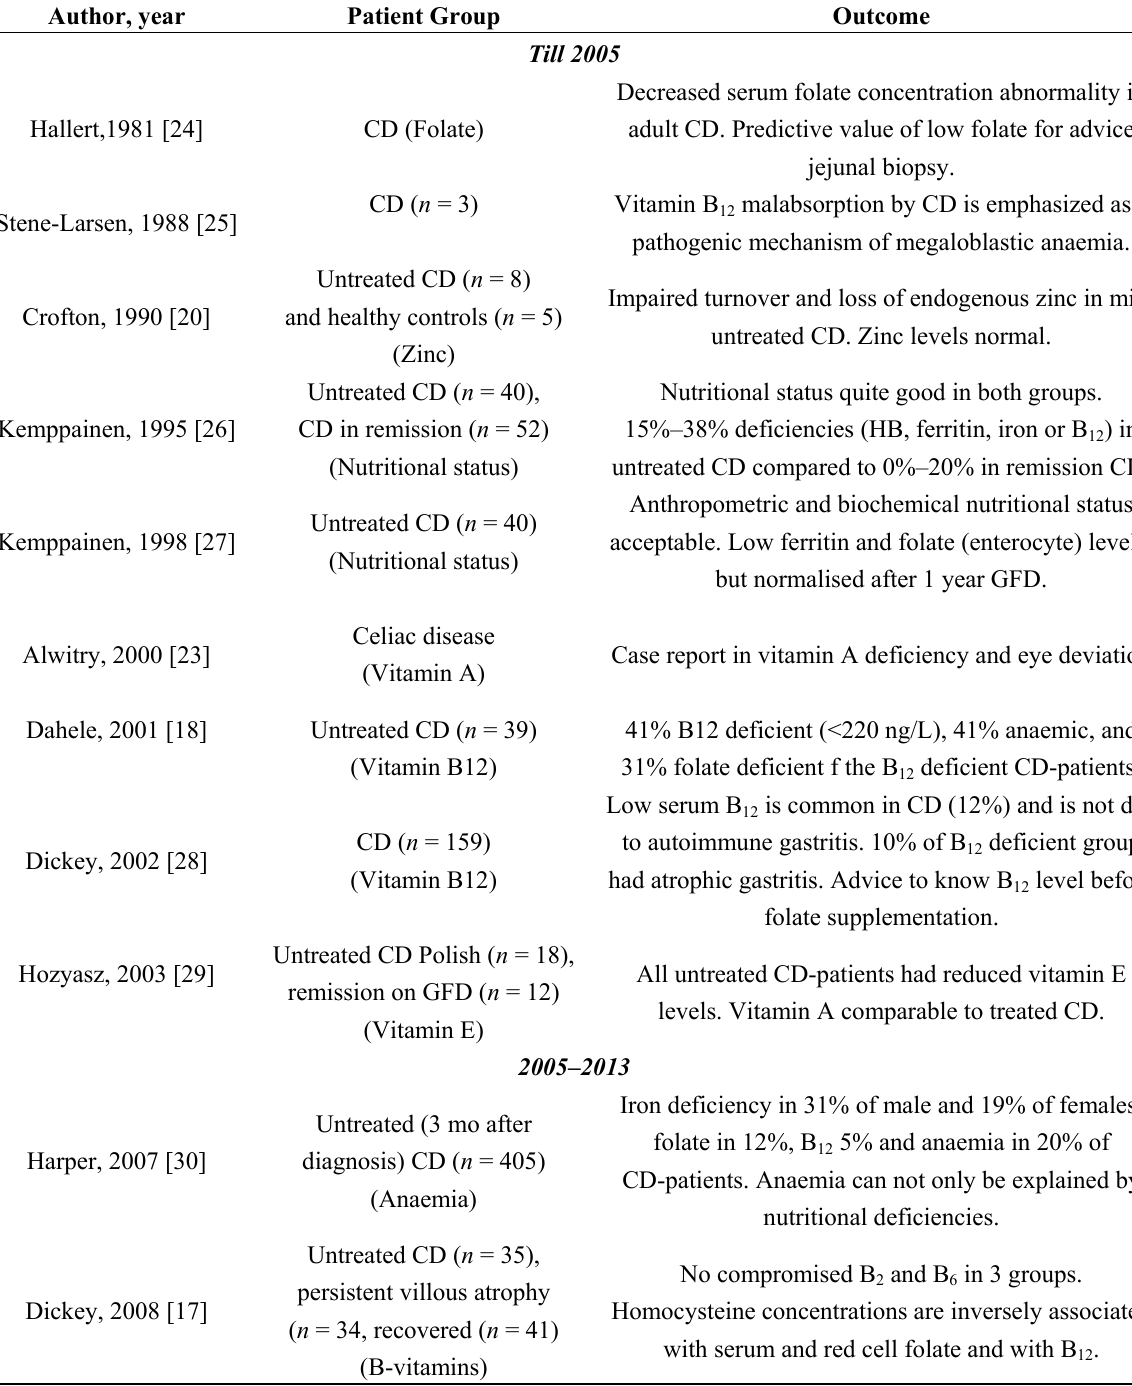
Table 1. Literature overview on vitamin and mineral status in newly diagnosed adult celiac disease